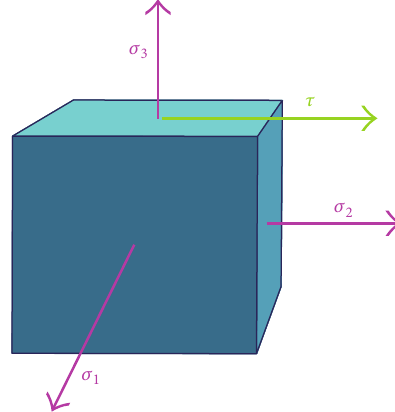
Figure 1: The model of multiaxial loading composed of the shear stress 𝜏 and normal stresses 𝜎 1 , 𝜎 2 , and 𝜎 3